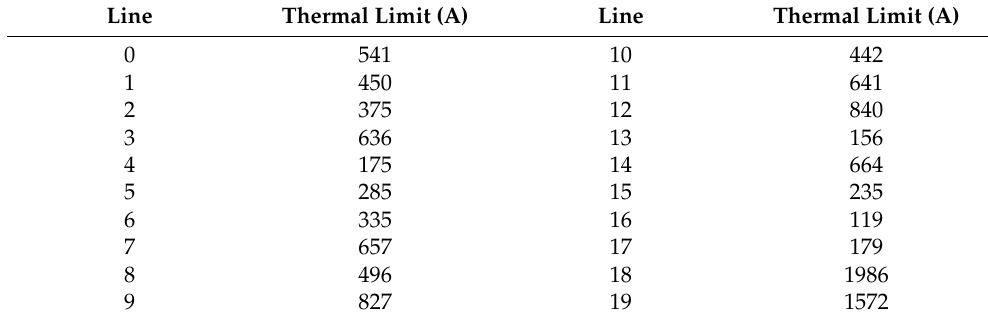
Table 1. Line thermal